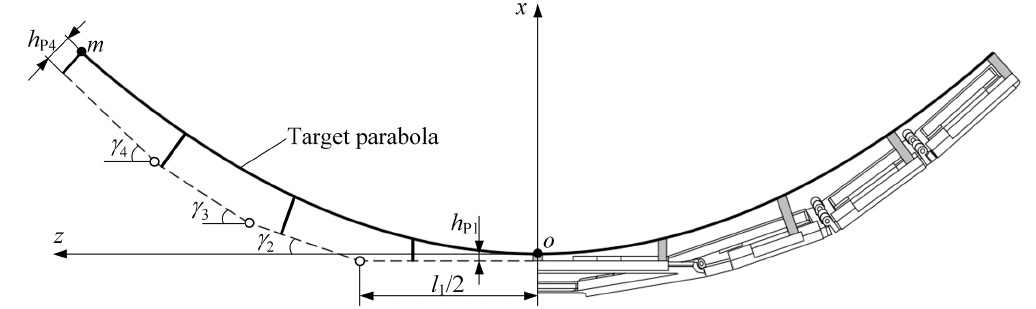
Figure 11. The cross-section of the parabolic cylindrical deployable